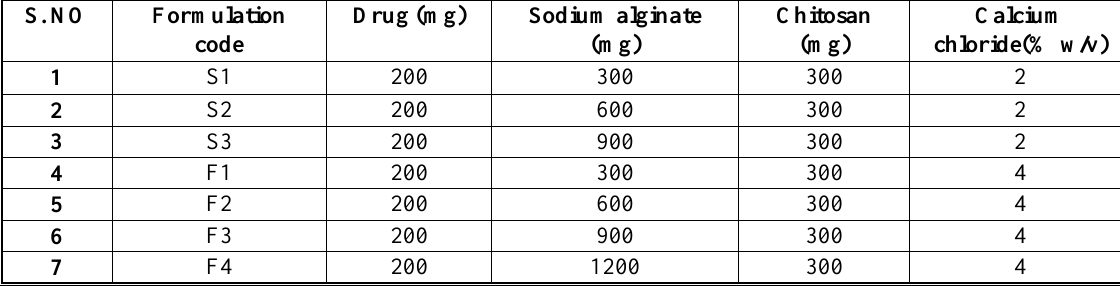
Table 1. Composition of acyclovir microspheres S.